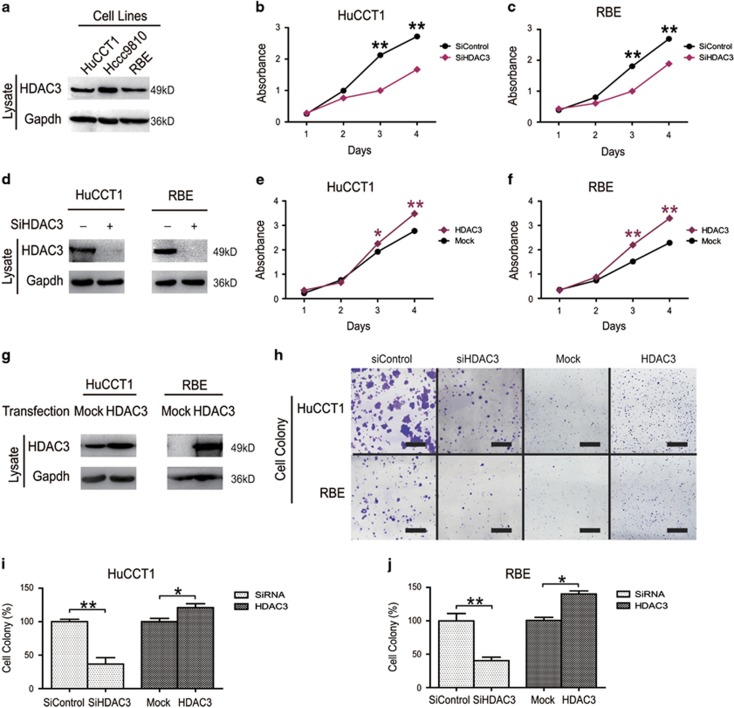
HDAC3 promoted growth in CCA cells. (a) HDAC3 protein levels were detected by western blot. (b and c) HuCCT1 and RBE cell proliferation was analyzed via CCK8 assay following small interfering RNA (siRNA) transfection. (d) Transfection efficiency was confirmed by western blotting. (e and f) HuCCT1 and RBE cell proliferation was analyzed via CCK8 assay following transfection with HDAC3 overexpression vector. (g) Transfection efficiency was confirmed by western blotting. (h) Cells were transfected with HDAC3 overexpression vector or siRNAs, and then colonies were stained with crystal violet and photographed. Scale bars, 1 cm. (i and j) Stained colonies were quantified. Data represent the mean±S.E.M., n≥3. *P<0.05 and **P<0.01